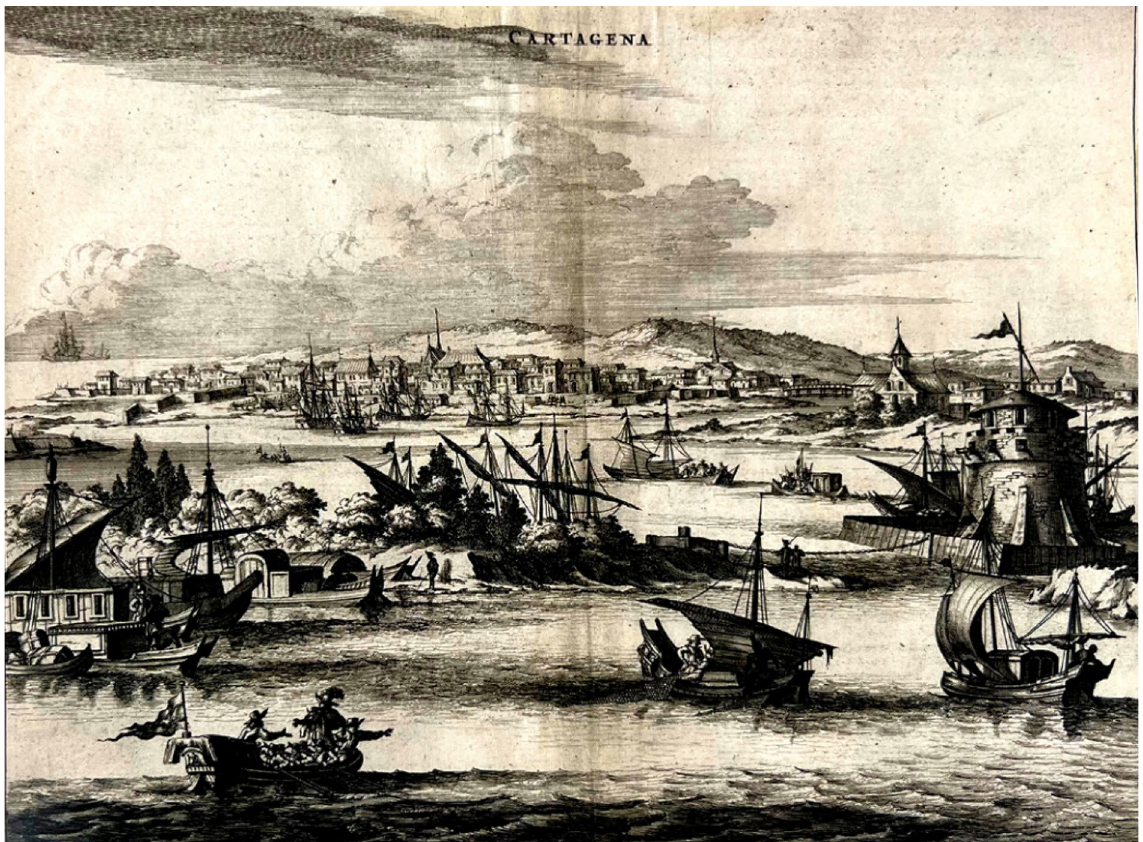
Fig. 7 Representation of the city of Cartagena de Indias made in the seventeenth century Source: State Archives, Ministry of Education, Culture and Sports of